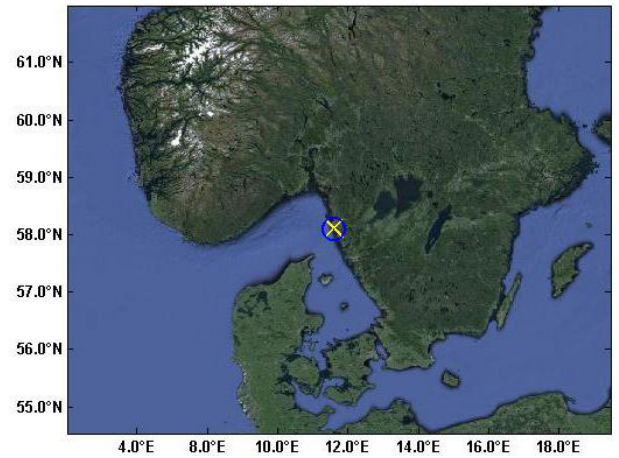
Figure 1. Location of the Lysekil wave energy test site.